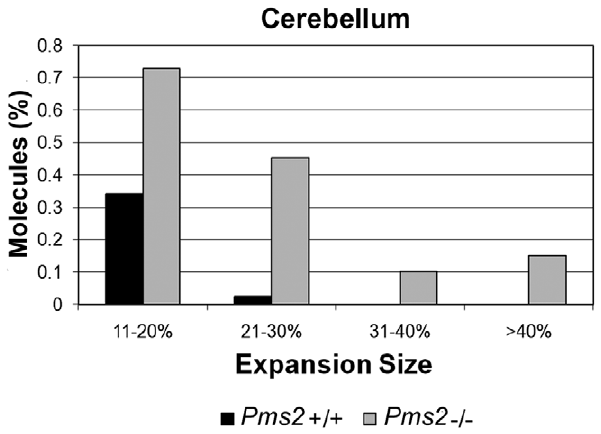
Figure 5. Absence of Pms2 results in larger expansions of the (GAA ? TTC) n sequence in cerebellum. SP-PCR was performed using approximately 80 molecules per reaction to detect rare large expansions. Expansion sizes were calculated as the percent increase, of number of repeats, from the longest progenitor. Expansions of at least 10% were considered large expansions. The size distribution of large expansions was significantly different between Pms2 + / + and Pms2 2 / 2 cerebellum ( P ,